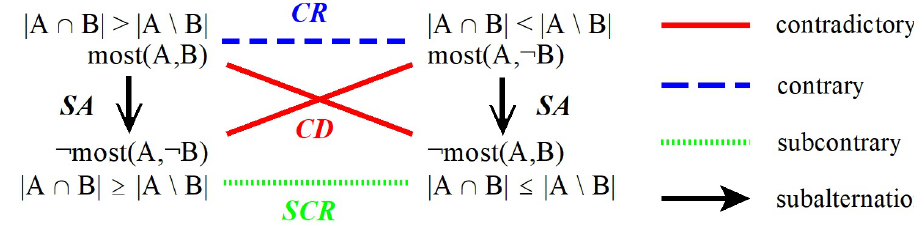
Figure 1. Classical Aristotelian square for the proportional quantifier ‘most’, relative to FOL .